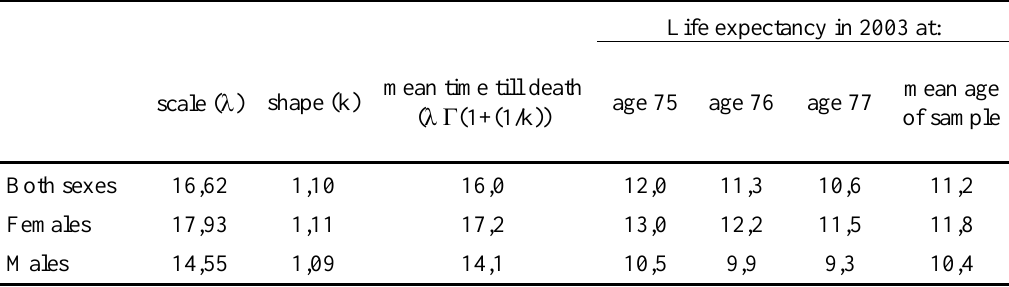
Comparison of sample-based estimates of mean survival time with life-table- based estimates of Swiss life expectancy in 2003 Life expectancy in 2003